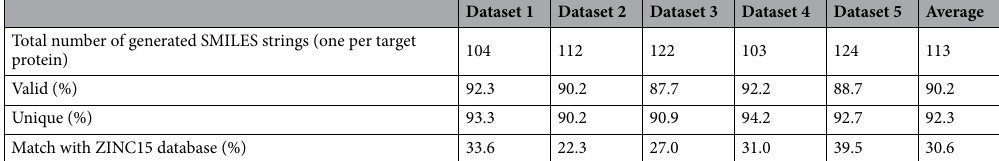
Table 2. Percentages of valid, unique and ZINC15 database-matched SMILES strings generated by the model in one per one